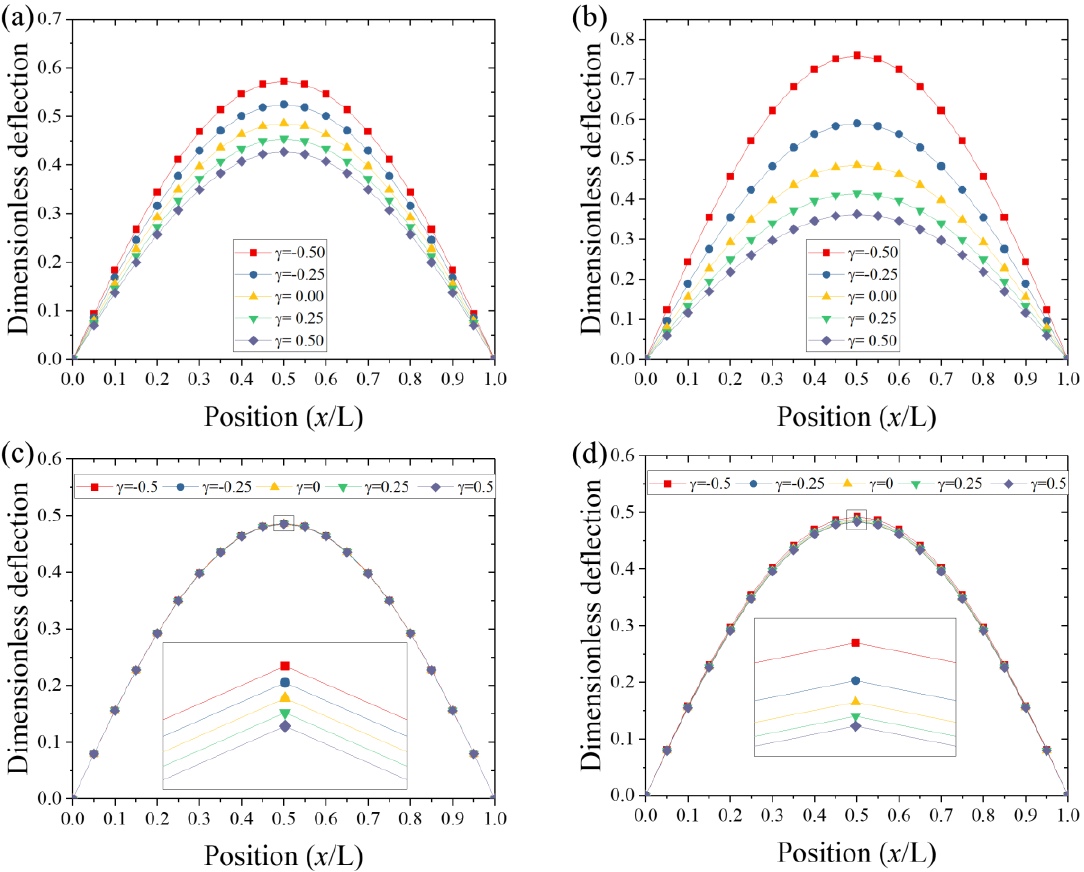
Figure 6. Dimensionless deflection along the axial direction: ( a ) Young’s modulus of aluminum; ( b ) Young’s modulus of alumina; ( c ) shear modulus of aluminum; ( d ) shear modulus of alumina. (a) The dimensionless deflection of the nanobeam decreases with the increase of the